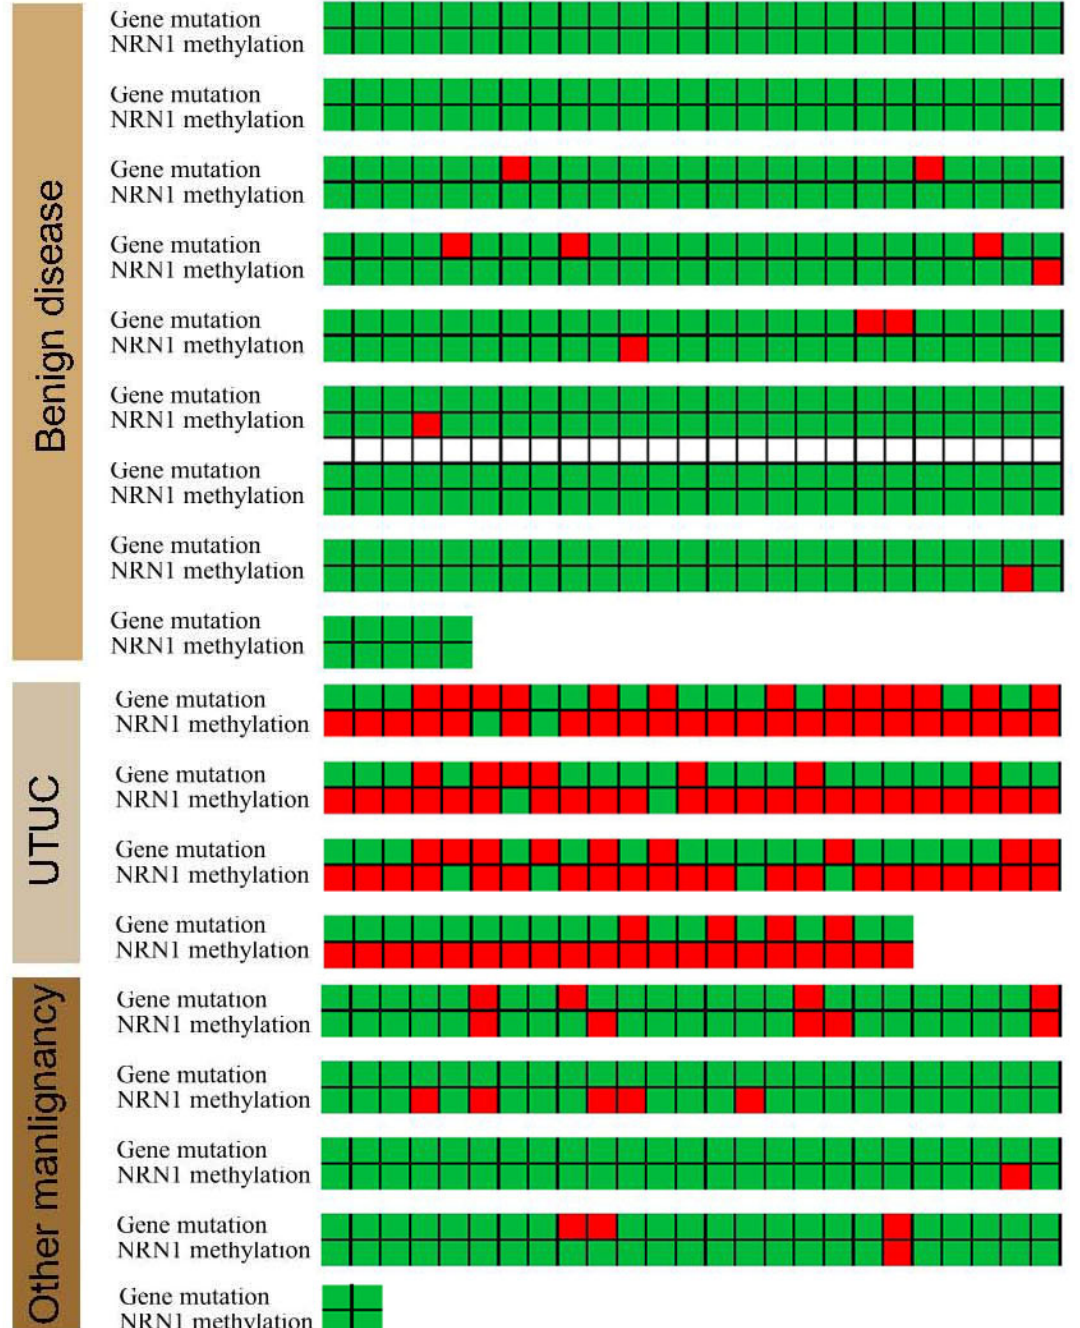
Figure 2. A heatmap showing details of mutated and methylated genes of the enrolled cases. Thir ‐ ty ‐ three (34.74%) UTUC patients exhibited mutated TERT or FGFR3 genes, whereas 3 (1.46%)